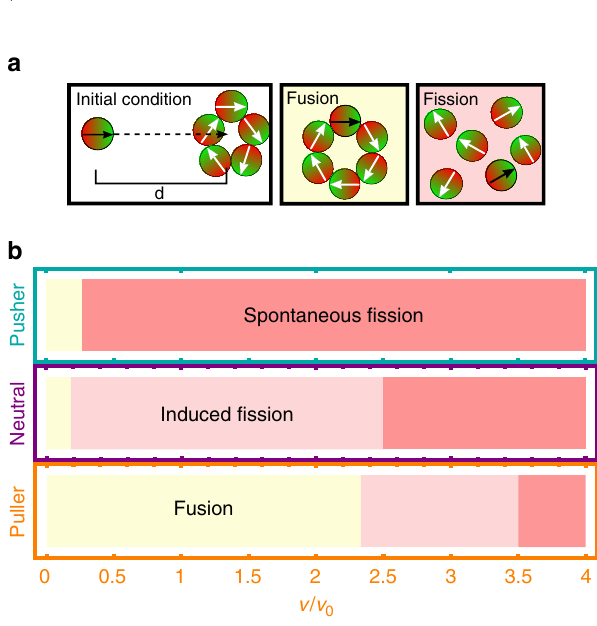
Figure 7 | Induced fission and fusion. ( b ) State diagram of the emerging scenarios for all three swimmer types and varied reduced self-propulsion velocity v / v 0 and respective snapshots, if a single swimmer collides with a ring-like cluster, see also Supplementary Movie 3. The initial set-up as well as the emerging characteristic structures are sketched in panel a .